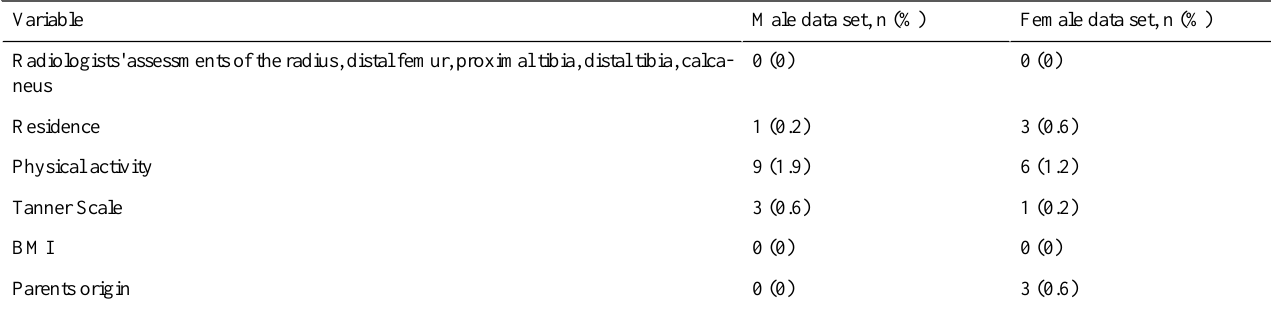
Table 3. Number of imputed instances and percentage over the male and female data